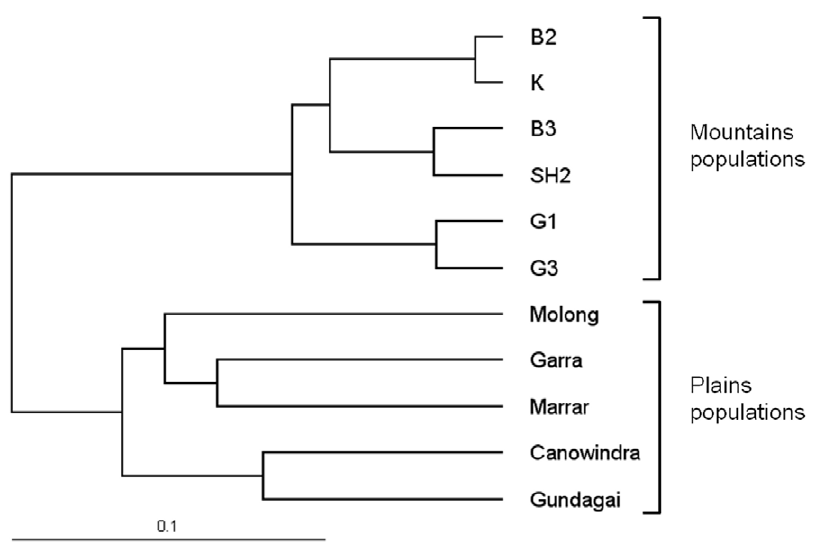
Figure 2. Tree of Nei’s genetic distances within and among Linummarginale populations from Mountains and Plains regions.